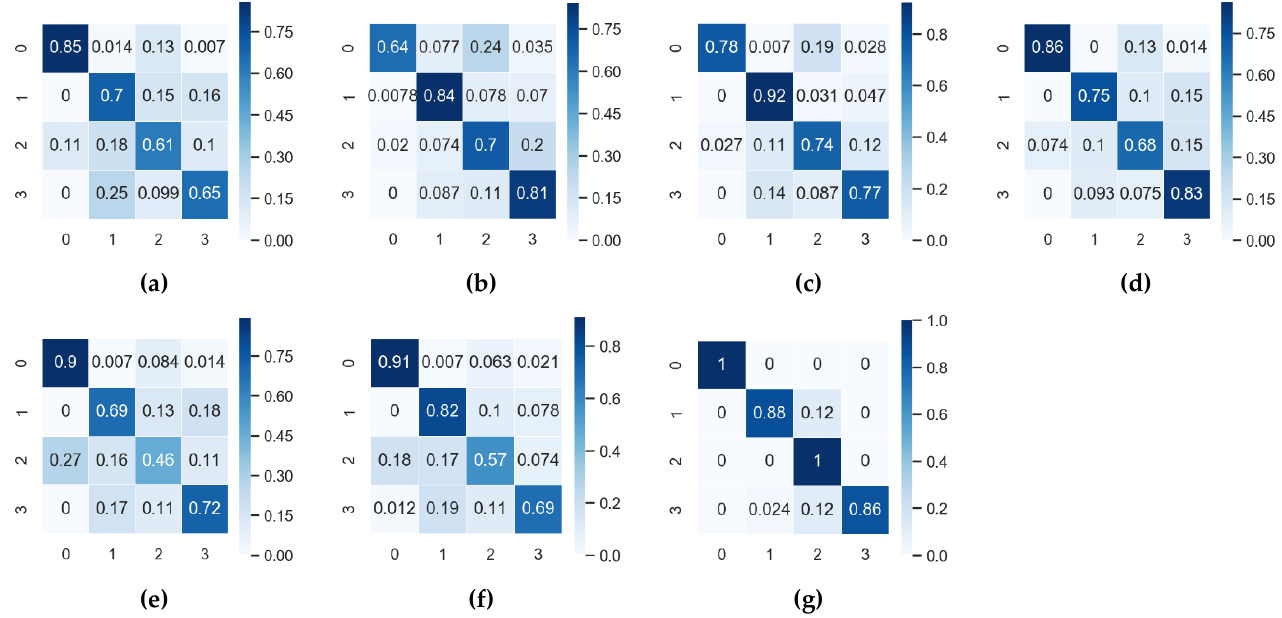
Figure 8. CM after ( a )DTC; ( b ) SVC-Linear; ( c ) SVC-RBF; ( d )RTC; ( e )GBDTC; ( f )XGBC; ( g ) Our method.